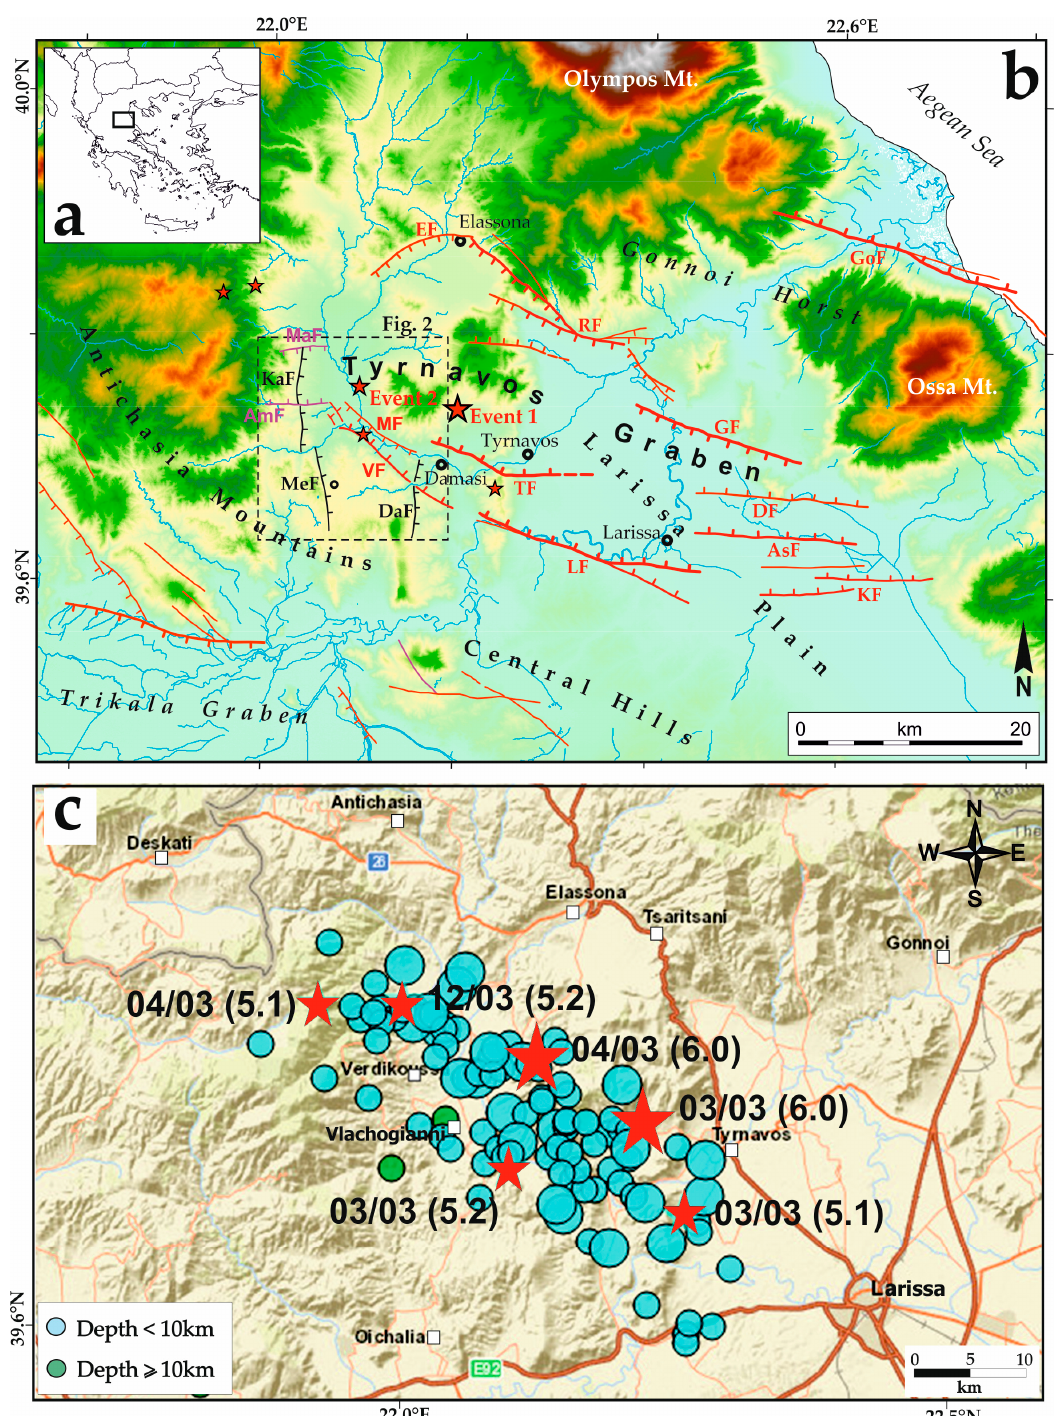
Figure 1. ( a ) Inset map of Greece showing the study area. ( b ) Tectonic map of the Tyrnavos Graben developed in northern Thessaly since Middle Pleistocene (modified from [4,7] and this study). ( c ) Simplified map showing seismic cluster with events >Mw 3.5 from 1 March 2021–15 July 2021 (data derived by https://bbnet.gein.noa.gr/HL/databases/database, accessed on 25 July 2021). Red stars in ( b , c ) indicate epicentres of major shocks (dimensions are proportional to magnitudes). Faults labels are as follows: EF: Elassona; RF: Rodia; GoF: Gonnoi; GF: Gyrtoni; MaF: Magoula; AmF: Ambelia; MeF: MegaloEleftherochori; MF: Mesochori; VF: Vlachogianni; TF: Tyrnavos; LF: Larissa; DF: Dimitra; AsF: Asmaki; KF: Kastri.